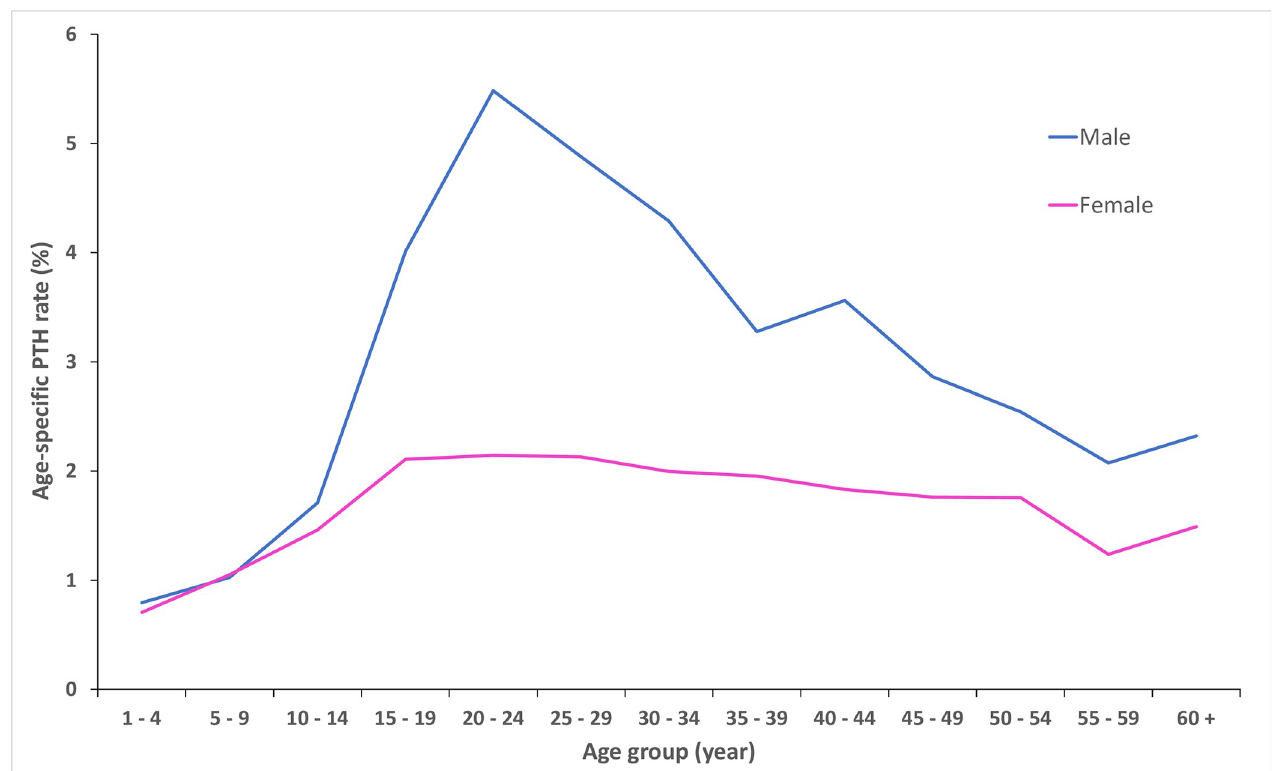
Fig 2. Gender and age specific rates of post-tonsillectomy haemorrhage in Australia, 2000–01 to 2019–20. Age-specific incidence rates of post- tonsillectomy haemorrhage (PTH) calculated by 5-year age groups for the male and female gender. Data obtained from the National Hospital Morbidity Database.